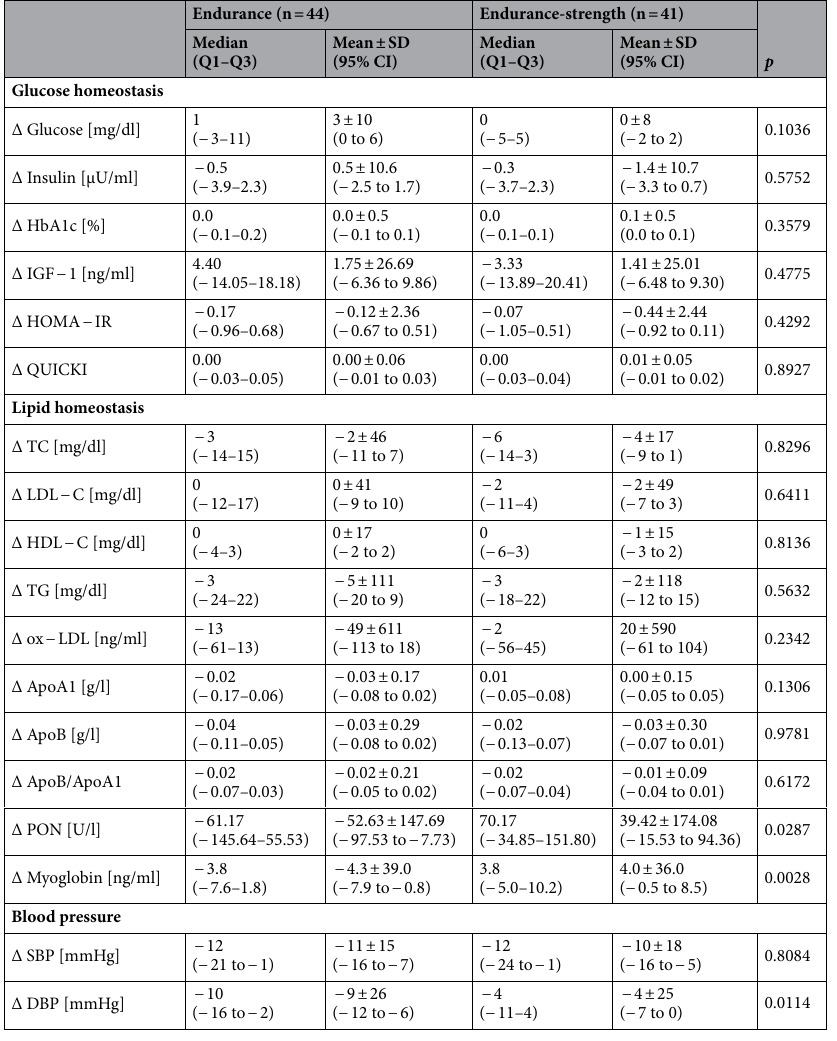
Table 6. Comparison of the mean difference of changes in cardiometabolic parameters and blood pressure between endurance and endurance-strength training using the ANCOVA test, adjusted for the baseline measures as a covariate. ApoA1 apolipoprotein A1, ApoB apolipoprotein B, DBP diastolic blood pressure, HbA1c glycated haemoglobin, HDL-C high-density lipoprotein cholesterol, HOMA homeostatic model assessment for insulin resistance, IGF-1 insulin-like growth factor, LDL-C low-density lipoprotein cholesterol, ox-LDL oxidized low-density lipoprotein, PON paraoxonases, SBP systolic blood pressure, TC total cholesterol, TG triglycerides, QUICKI quantitative insulin sensitivity check